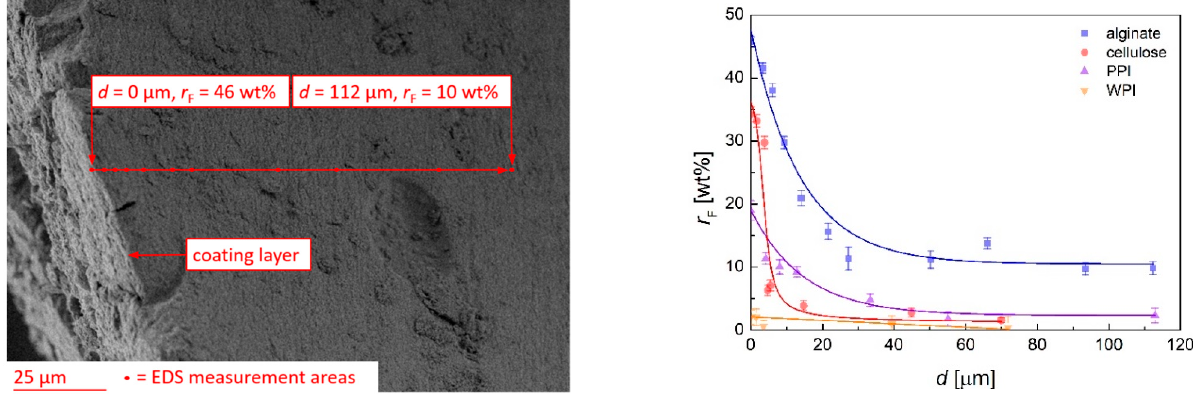
Figure 7. SEM picture of cut-open alginate aerogel substrate with external coating and inner porous part ( left ). Points mark the areas according to EDS measurements. Fluorine content depending on the distance from outer layer ( right ). Error bars represent the error of the individual measurements; solid lines illustrate the course of r F for different aerogels. All measurements were performed for aerogel substrates treated under the following process condition: C 4 F 8 , CW, p input = 90 W, t = 50 min.